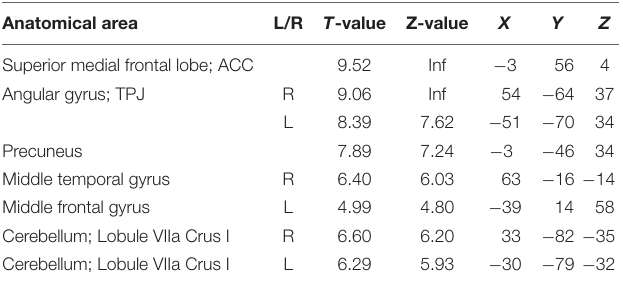
TABLE 2 | HRF model; negative modulation p < 0.05 (FWE corrected at the voxel level). Anatomical